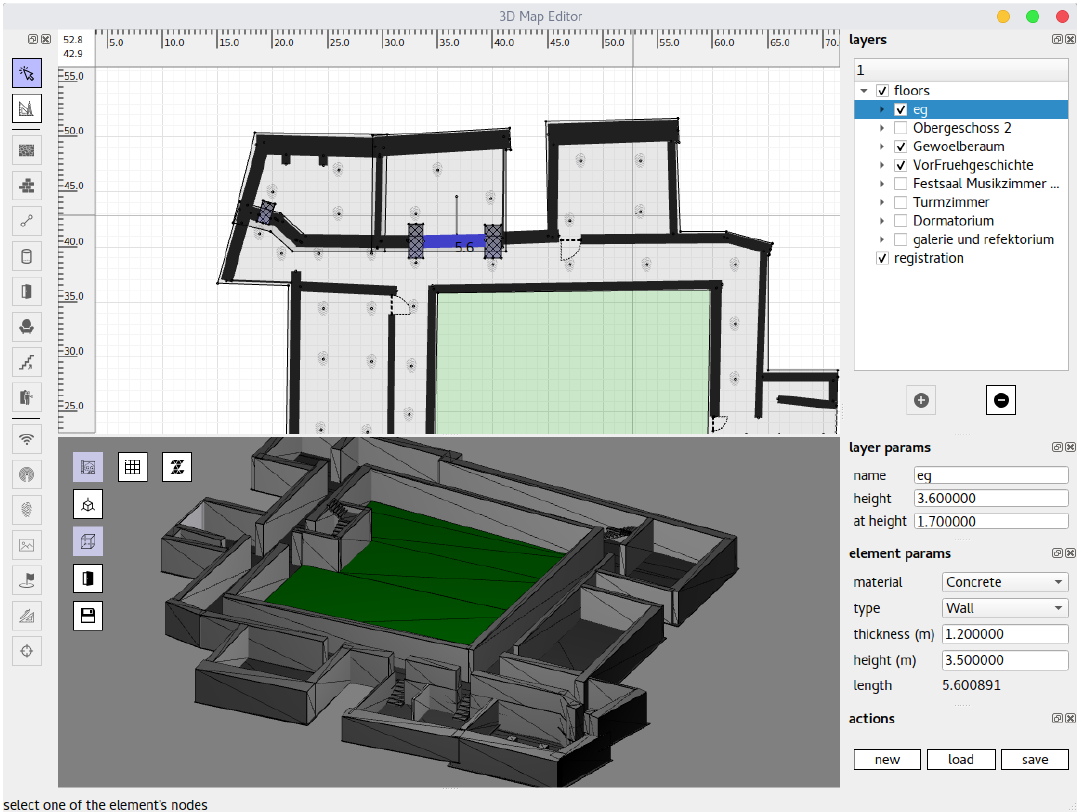
Figure 4. The 3D map editor we developed to create the floor plans. This screenshot shows the ground level of the building. The window is split into toolbar (left), layers (upper right), parameters of current selection (lower right), drawing mode (upper center) and 3D view (lower